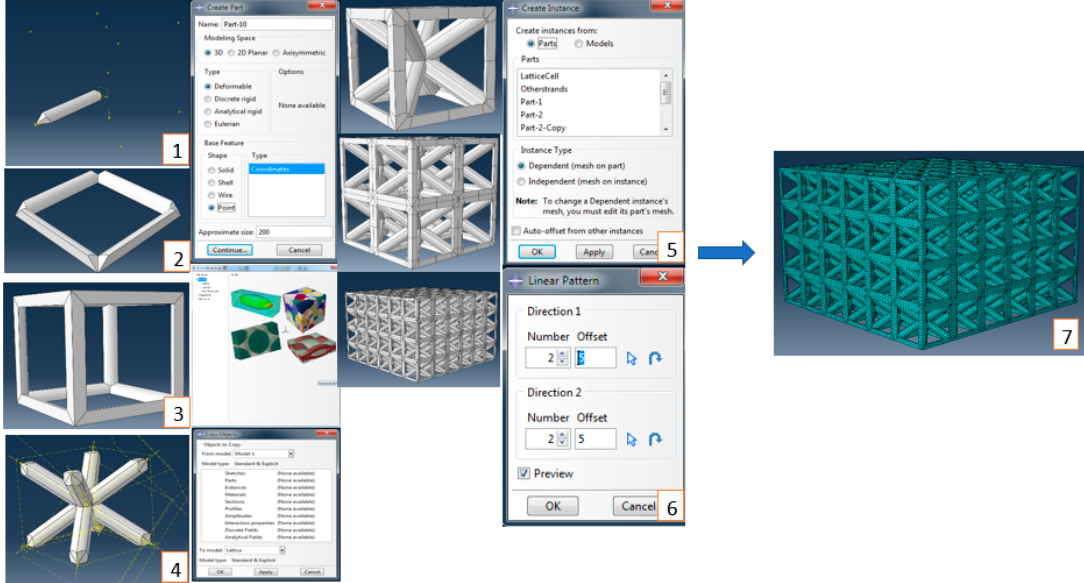
Figure 5. Framework for developing micromechanics technique using ABAQUS.